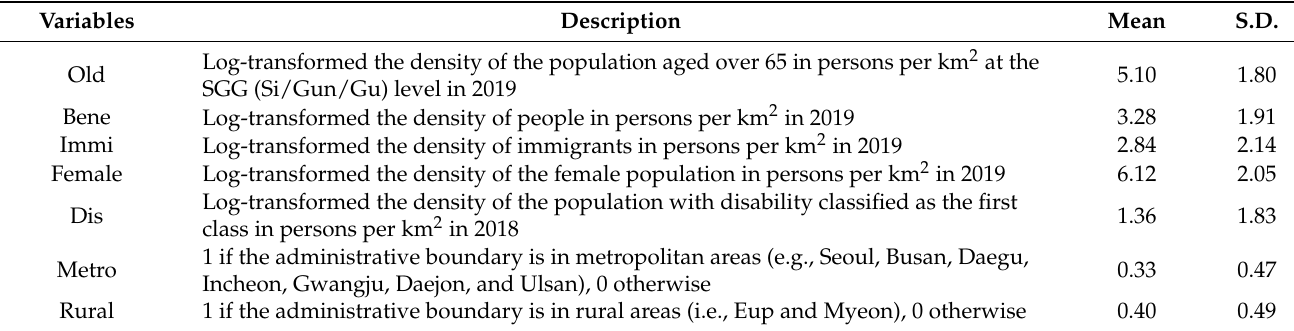
Table 3. Description of Independent Variables Used in Multilevel Regression